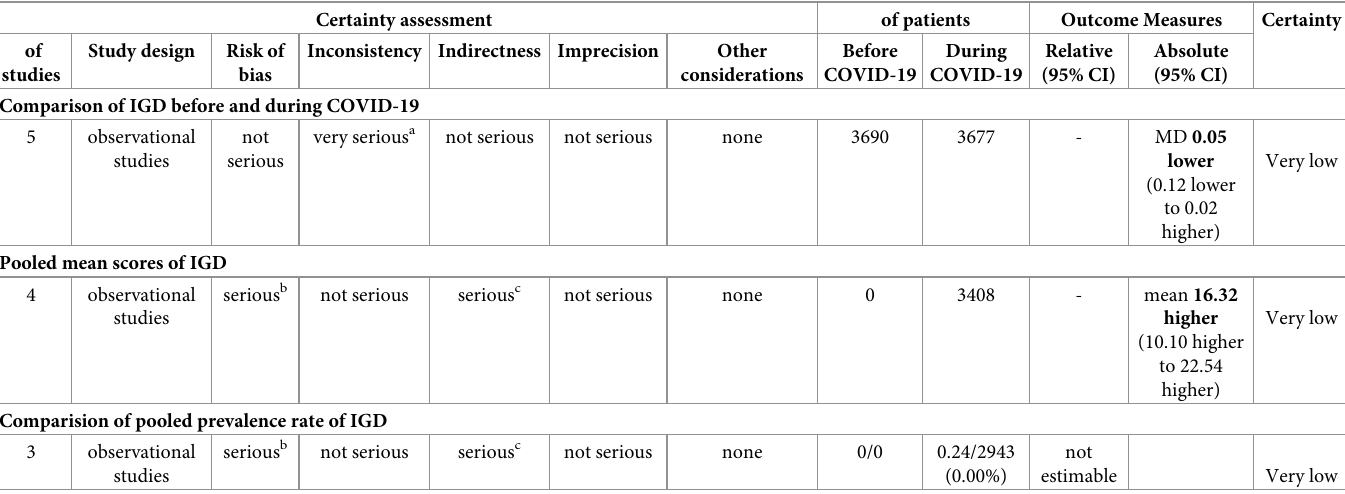
Table 3. Assessment of certainty of evidence through